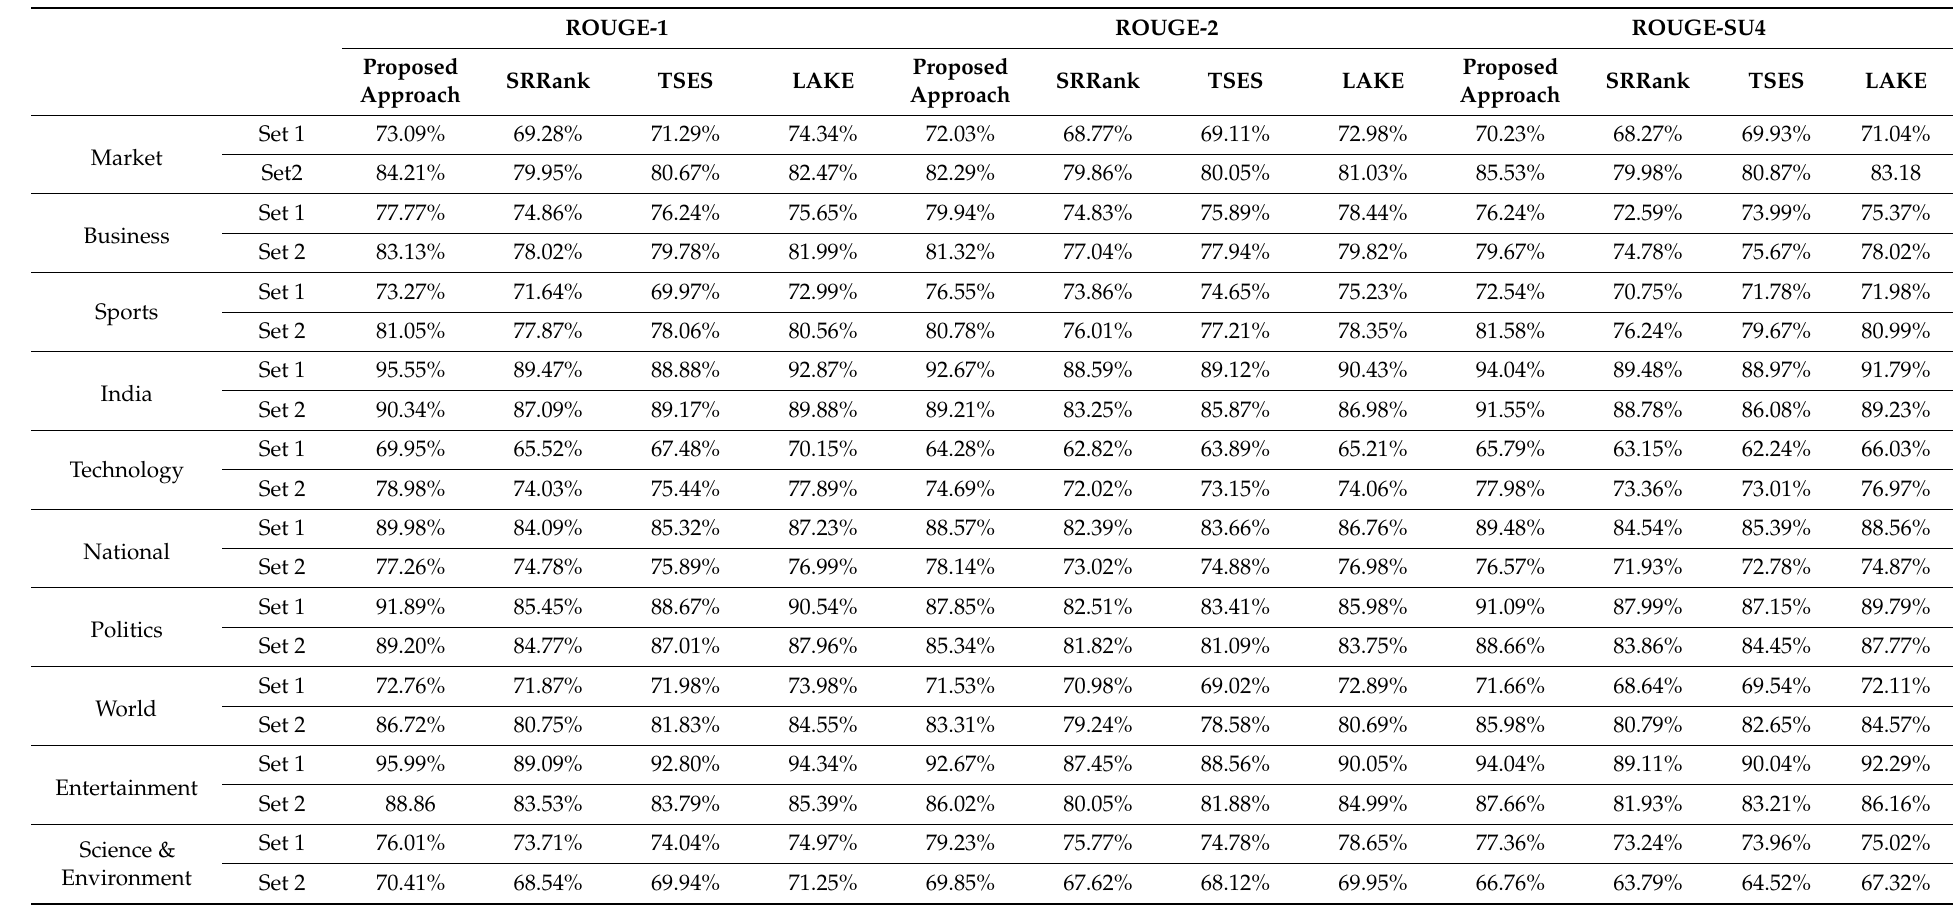
Table 7. Experimental evaluation of